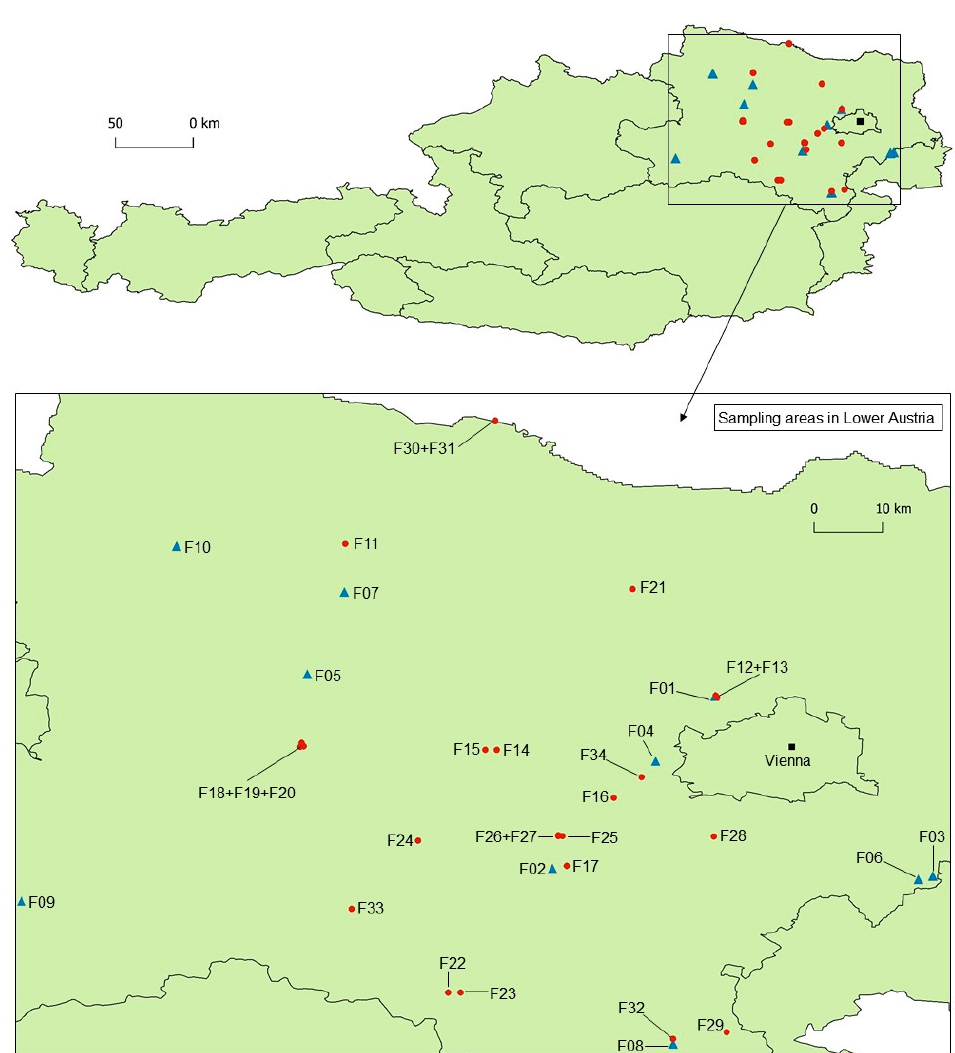
Figure 1. Location of Lower Austria within Austria (small rectangle) and the detailed location of the 10 intensively surveyed (F01–F10; blue triangles) and the 24 extensively surveyed (F11–F34; red dots) beech forest stands included in the Phytophthora survey in Lower Austria. For GPS coordinates, see Tables 1 and 2.